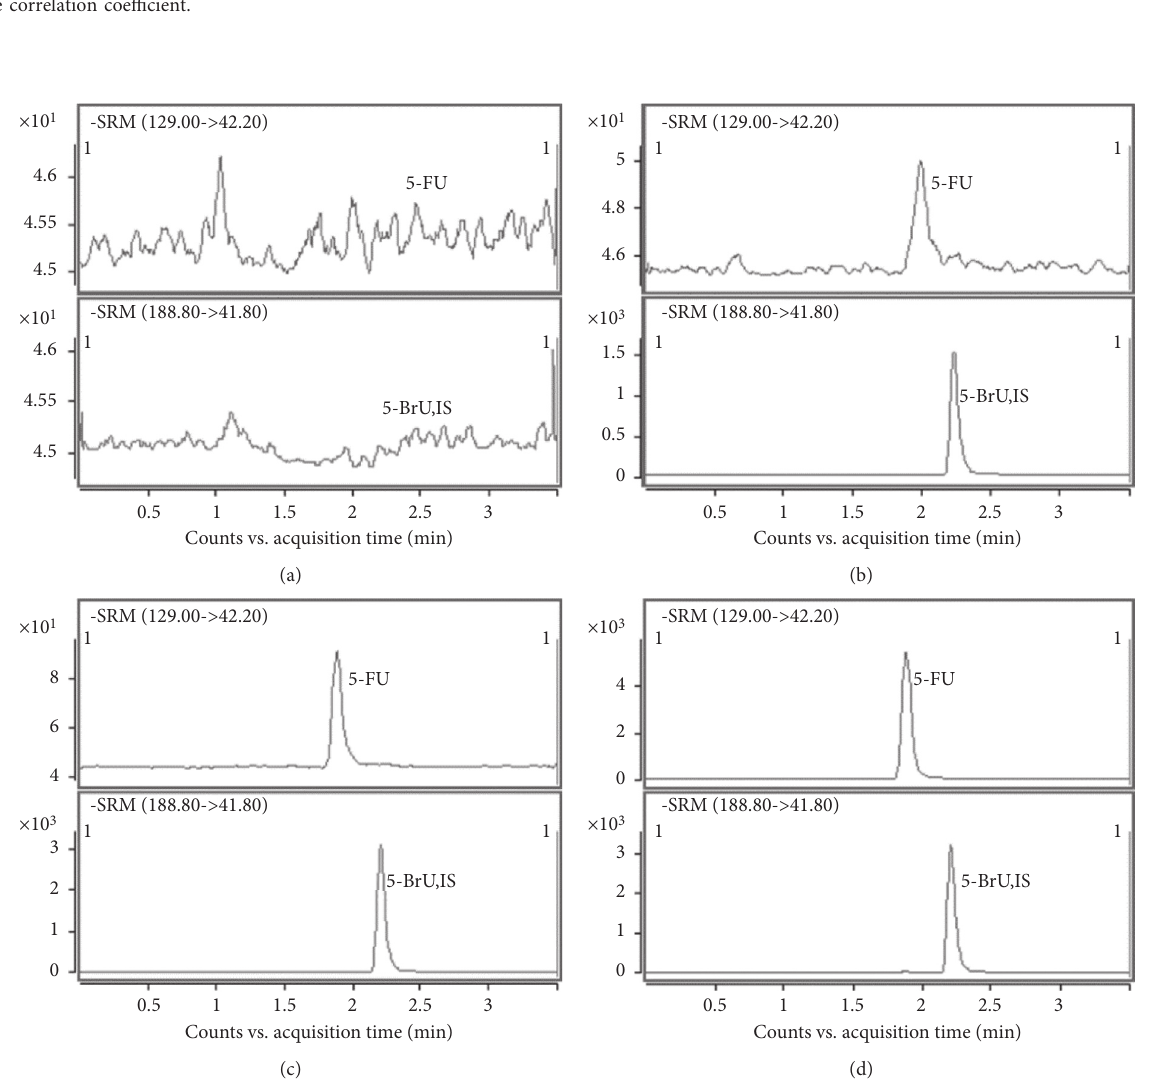
Figure 2: Representative SRM chromatograms for the specificity of 5-FU. (a) Blank sample; (b) blank sample spiked with IS; (c) LLOQ sample; (d) real sample.